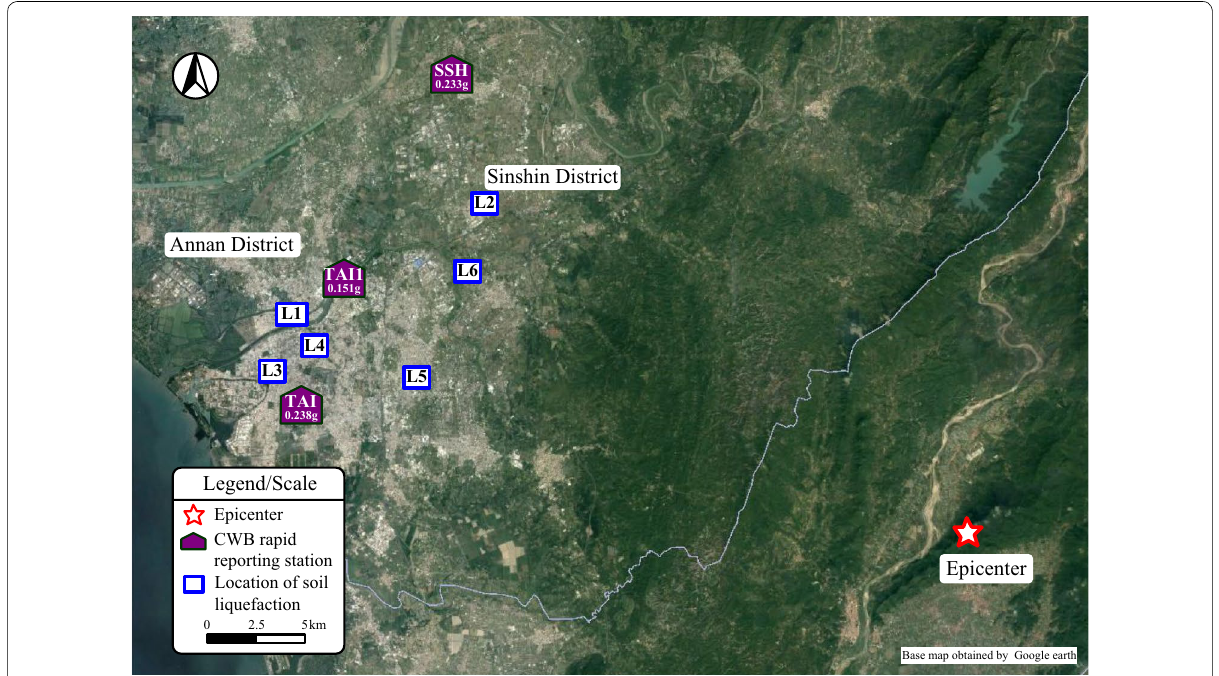
Fig. 1 Locations of liquefaction sites, epicenter and seismic stations